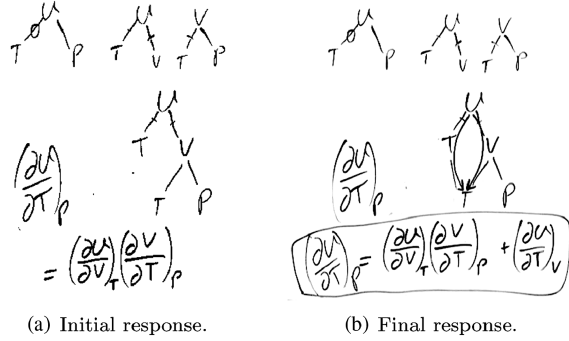
FIG. 11. Snapshots of student 1 ’ s tree diagram method. Student 1 added the paths in the tree diagram and the extra term in the PD expression after the interviewer ’ s